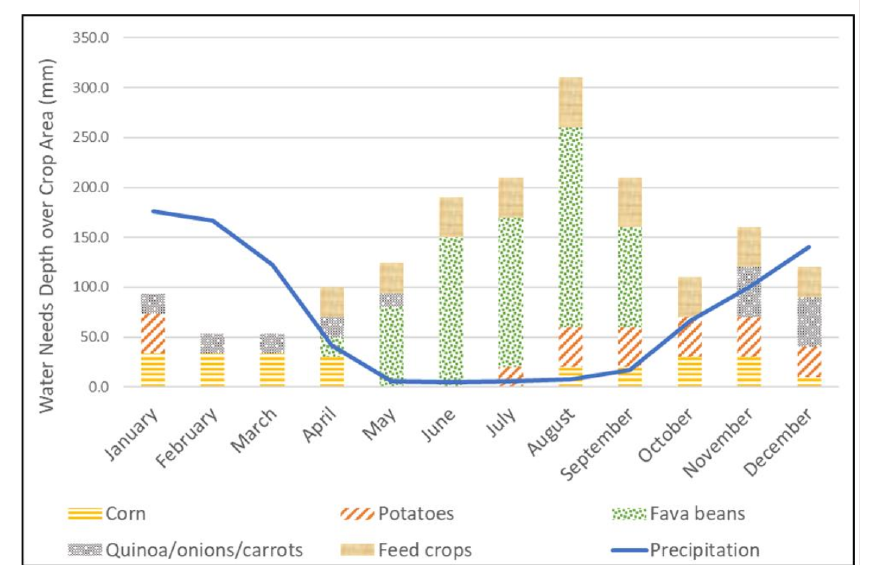
Figure 5. Average monthly precipitation (mm) and typical monthly irrigation needs (mm) for major crops grown in Zurite. The need for water is most acute in the dry winter to irrigate fields of fava beans, feed crops, and recently planted corn (August-November). Figure by W. Wunderlich and A.